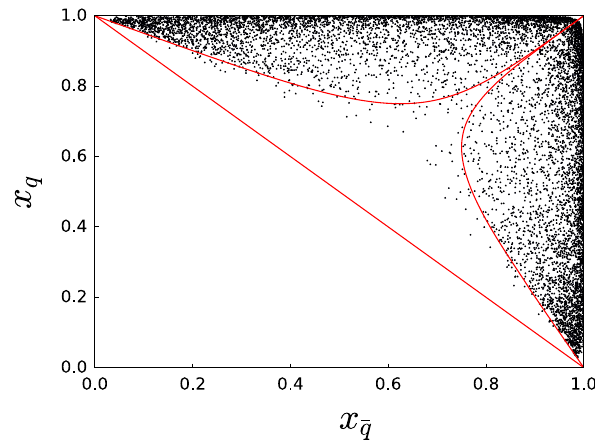
Fig. 2 Dalitz plot for e + e − → q ¯ qg showing the region of phase space filled by one emission from the quark and antiquark in the angular- ordered parton shower. The line shows the limits for the parton-shower emission. x i = 2 E i / Q where E i is the energy of parton i and Q is the centre-of-mass energy of the collision